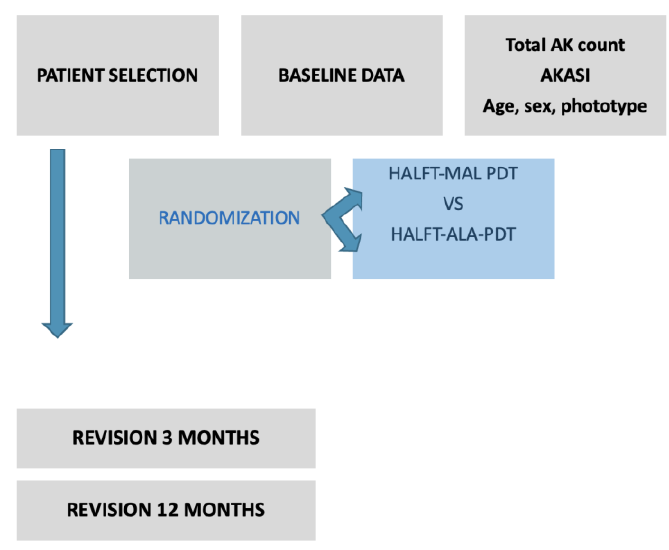
Figure A1. Diagram of the study.